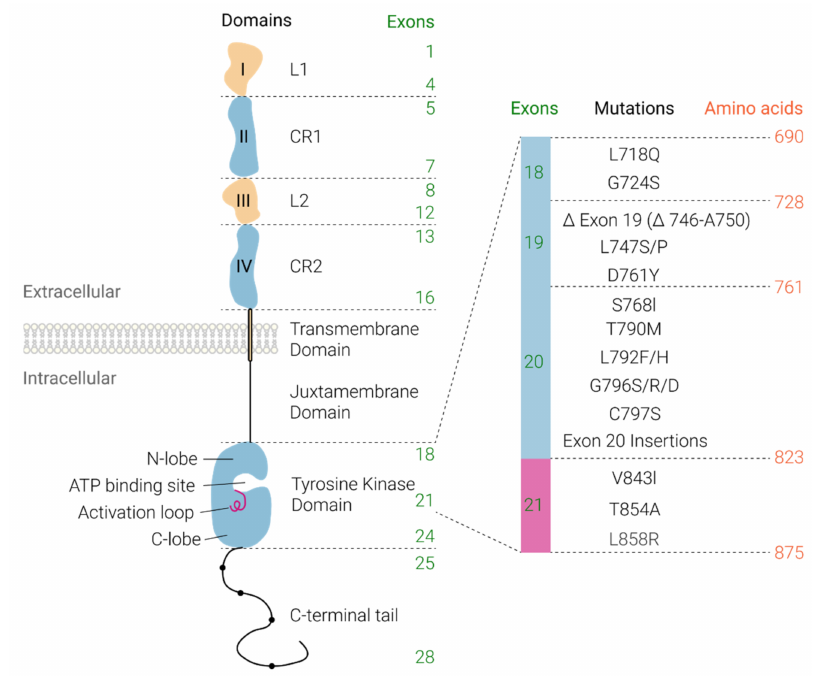
Figure 1. A schematic representation of EGFR illustrating exon boundaries and associated extracel- lular, transmembrane, and intracellular protein domains. The extracellular domain is involved in ligand binding (Domains I and III) and dimerisation (Domain II). The intracellular domain contains a juxtamembrane domain, tyrosine kinase domain, and multiple C-terminal tyrosine residues (circles), which are phosphorylated on ligand binding and receptor activation leading to the activation of cell proliferation, survival, migration, and/or angiogenesis signalling pathways. The tyrosine kinase domain is expanded to show relevant mutations associated with resistance and sensitivity to first-, second- and third-generation tyrosine kinase inhibitors as discussed in Table 3. (large EGF binding domain 1, L1; cysteine-rich domain 1, CR1; large EGF binding domain 2, L2; and cysteine-rich domain 1,